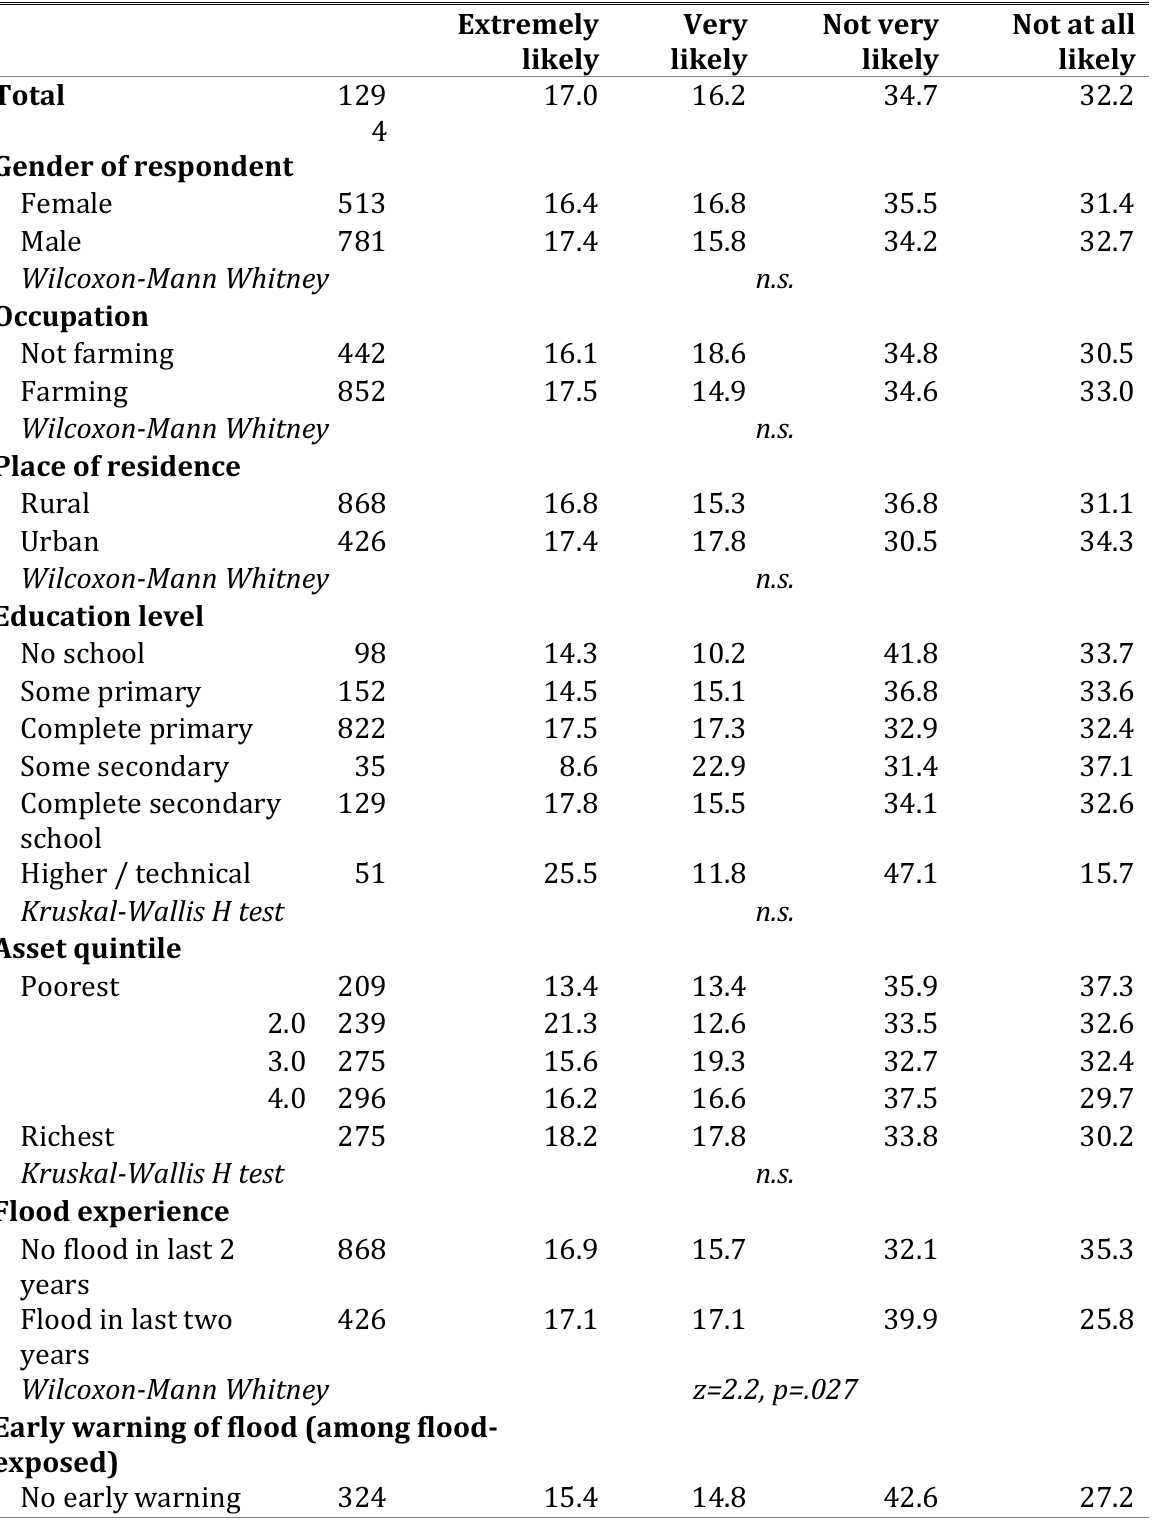
Table A1.4. Perceived capacity to be prepared for an extreme flood by respondent